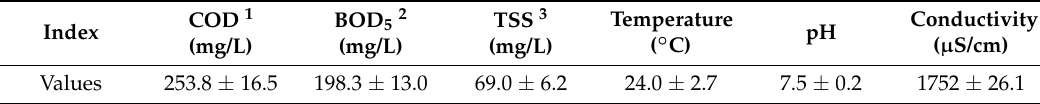
Table 1. Physical and chemical characteristics of the synthetic domestic